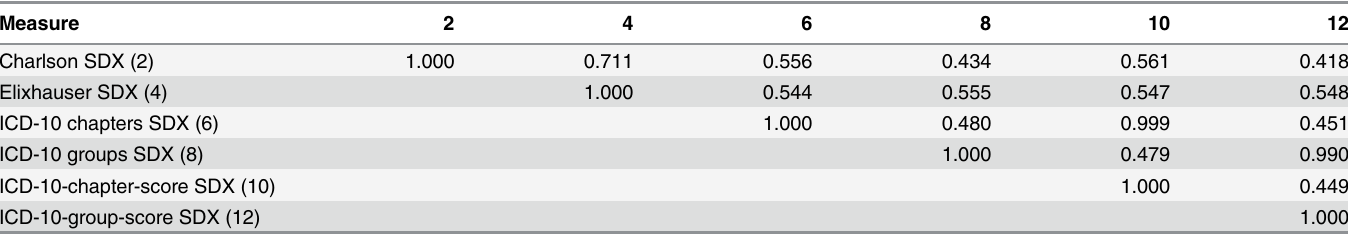
Table 3. Non-parametric correlation coefficient from the correlation analysis of the comorbidity measures excluding the PDX. Measure 2 4 Charlson SDX